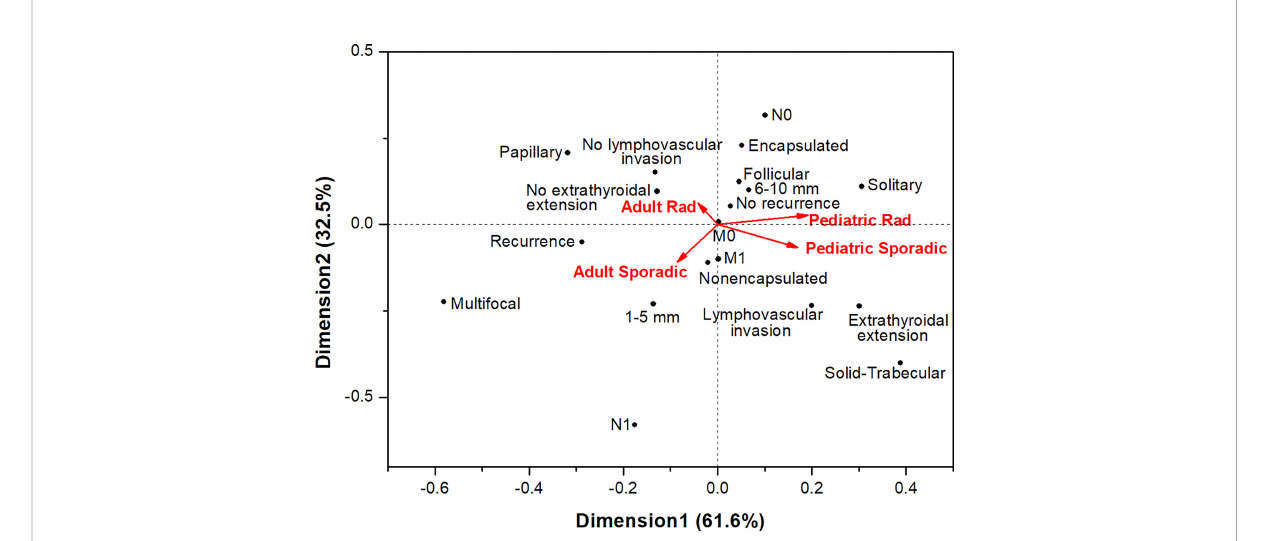
FIGURE 2 Correspondence analysis of the associations of papillary thyroid microcarcinomas of different etiology from pediatric ( ≤ 18-year-old.) and young adult (19-30-year-old) patients with the major histopathological characteristics, tumor invasive features and recurrence.